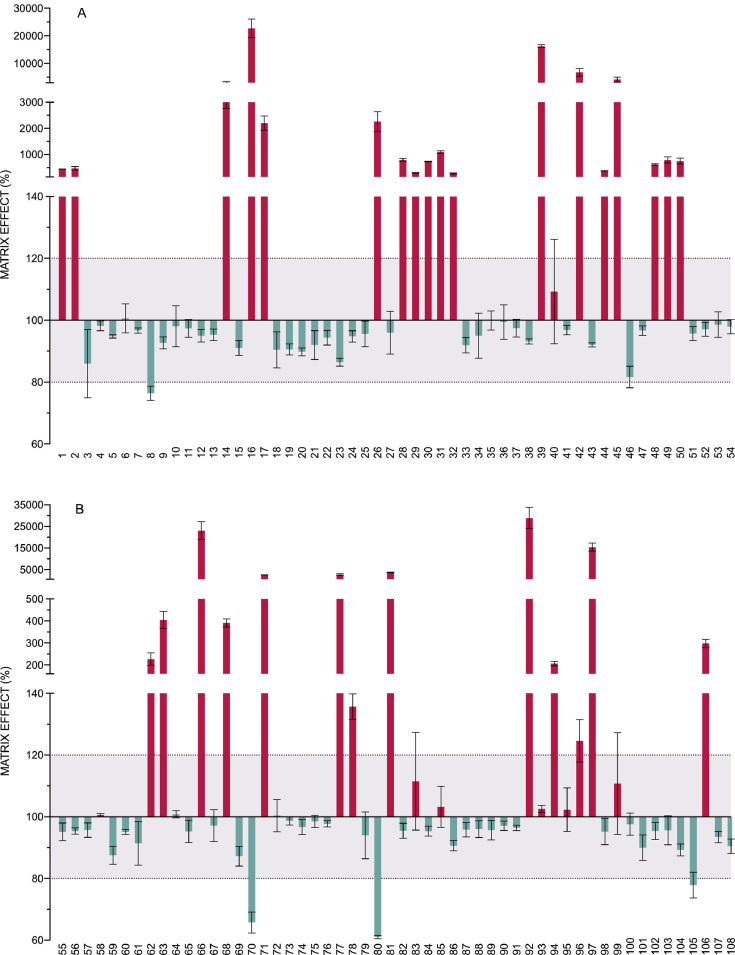
Matrix effect. Bars represent the mean and SD of the recoveries of the 218 analytes (spiked soil extract quantified against a calibration curve prepared in solvent). The compounds are numbered according to the relation in Table 1. Dotted lines represent the tolerance range in which it is considered that no significant matrix effect exists. For clarity the graph has been divided in 4 panels.